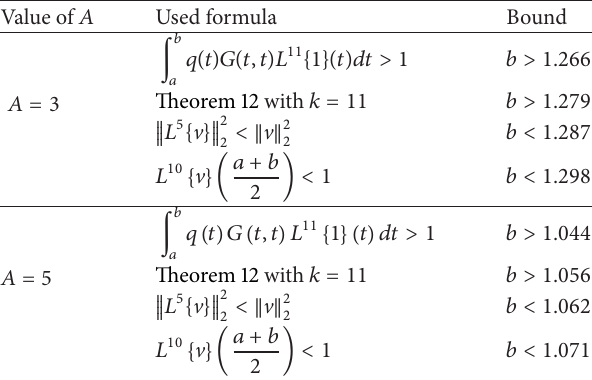
Table 4: Comparison of bounds for 𝑏 in Example 4. Value of